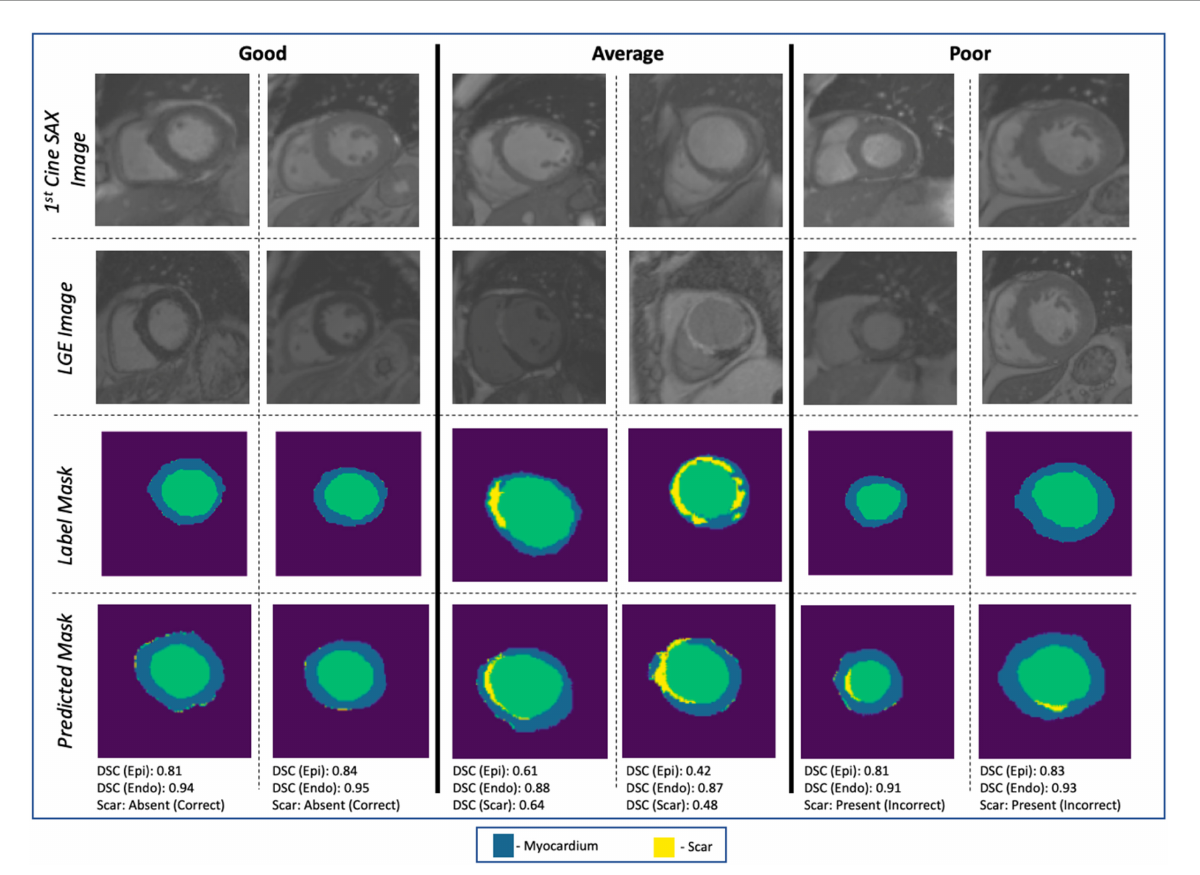
FIGURE6 Examples of image segmentation results. The “Good” (correctly identifying the absence of myocardial scar due to MI), “Average” [correctly identifying the presence of the scar with DSC ∈ ( 0 . 4 , 0 . 65 ) ], and “Poor” (incorrect identification of the presence of the scar). Cases with DSC < 0 . 4 are not shown in the